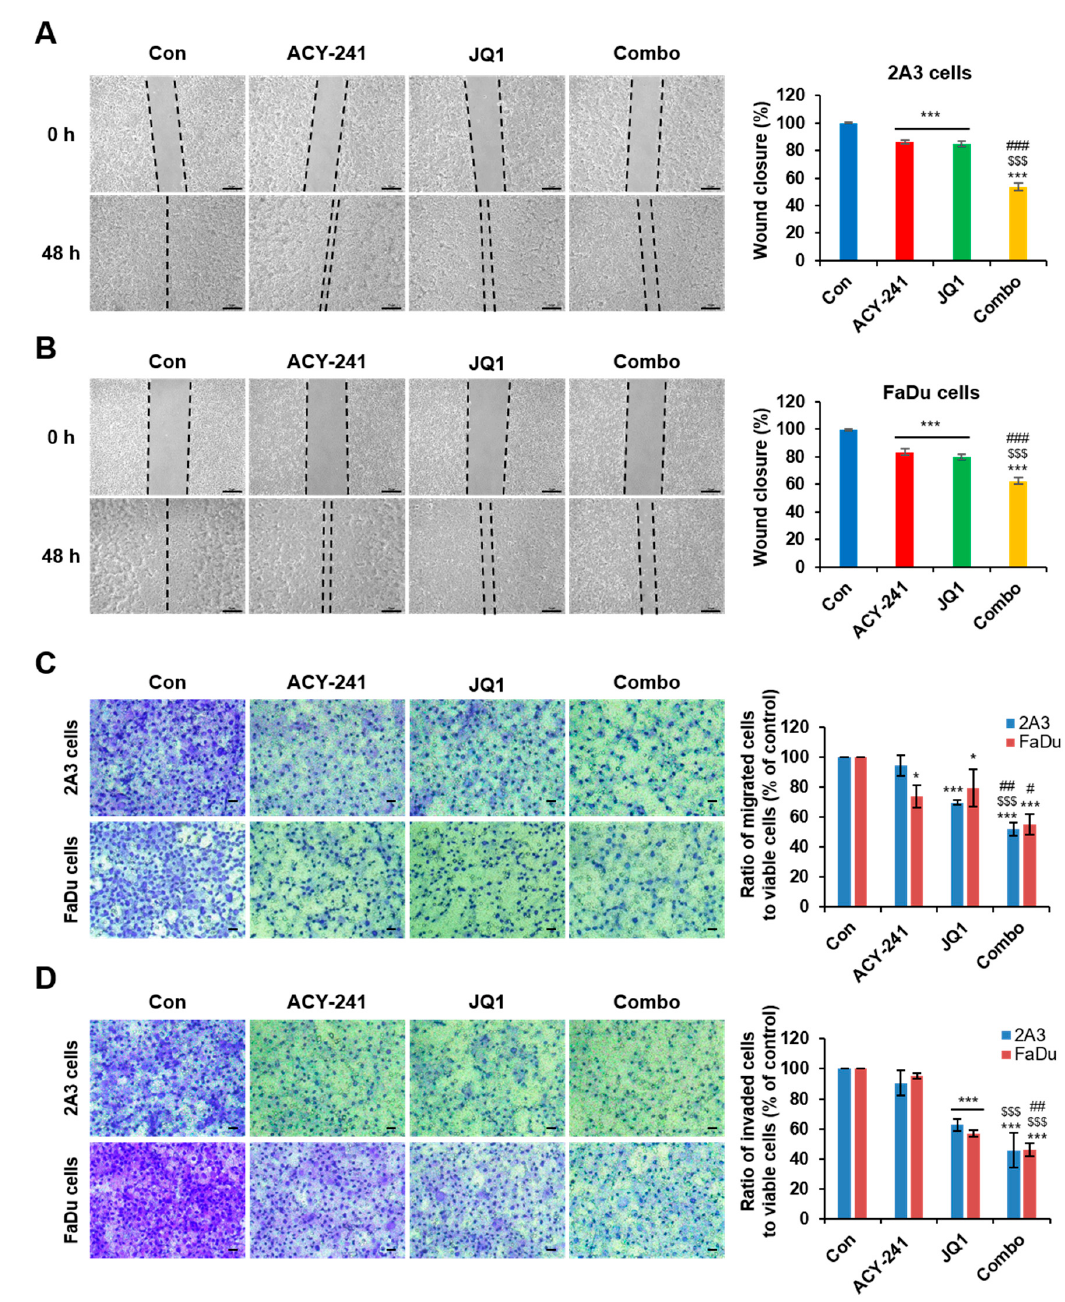
Figure 5. Combination treatment of ACY-241 and JQ1 synergistically inhibit HNSCC cell invasion and migration. ( A , B ) Wound healing assay of 2A3 and FaDu cells. Cells were seeded in 6-well plates and then scratched after cell adhesion. Artificial lines were drawn on microscopic images to visualize the scratched area. Percentage of wound closure was determined by the di ff erence between wound areas in 0 h and 48 h. The wound was photographed at 50 × magnification. Scale bar = 50 µ m. ( C ) Transwell migration assay and ( D ) transwell invasion assay of 2A3 and FaDu cells. The cells were photographed at 200 × magnification. Scale bar = 100 µ m. Matrigel (0.4 mg / mL) was coated on the inner inserts of transwell plate for 1 h during invasion assay. Cells were treated with 0.2% DMSO, ACY-241 (4 µ M), and JQ1 (2 µ M) alone or in combination for 48 h. Data were normalized by cell viability to represent migration and invasion of viable cells. Values represent mean ± SD ( n = 3). * p < 0.05, or *** p < 0.001 vs. DMSO control, $$$ p < 0.001 vs. ACY-241-treated group, # p < 0.05, ## p < 0.01 or ### p < 0.001 vs. JQ1-treated